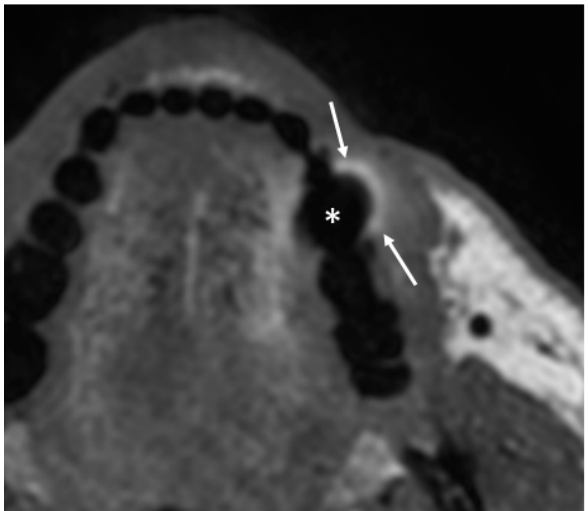
Figure 21. MRI “pile-up” artifact. The high magnetic susceptibility within the magnetic field could accumulate the signal intensity in the region of interest resulting in an abnormally high signal (“pile- up artifact”, indicated by white arrows). “Pile-up artifact” mainly occurs on the periphery of the area produced by magnetic distortions and signal loss given by the interface between dental metal materials and adjacent tissues (*).